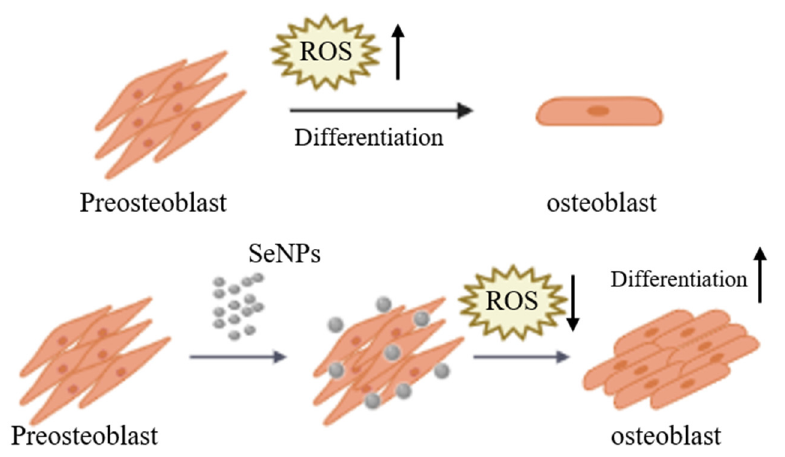
Figure 7. Schematic diagram of MC3T3-E1 cells cultured and treated with SeNPs for osteogenic differentiation. ROS increase during the differentiation of pre-osteoblasts into osteoblasts. SeNP treatment regulates ROS to protect cells from ROS and is also involved in cell differentiation.